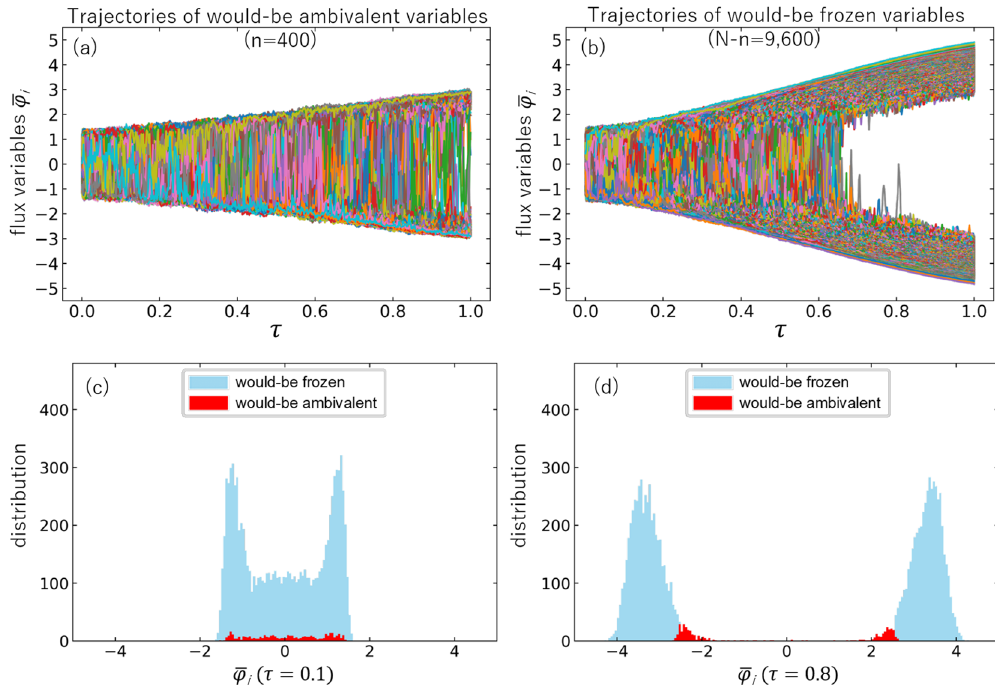
Figure 4. ( a ) Trajectories of would-be ambivalent variables ϕ i ′ with i ′ = 1, 2, . . . , n . ( b ) Trajectories of would-be frozen variables ϕ i ′ with i ′ = n + 1, . . . , N . Here, n and N are taken to be 400 and 10,000,